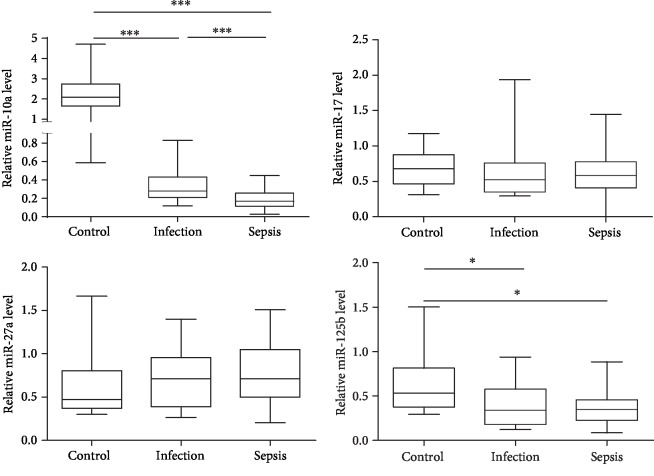
PBMC miR-10 levels in sepsis. The box and whisker plots represent the levels of miR-10a, miR-17, miR-27a, and miR-125b in PBMC of healthy controls (n = 20), infection patients (n = 21), and sepsis patients (n = 41). The plot shows the median (lines within boxes), interquartile range (bounds of boxes), and error bars (upper and lower ranges). ∗p < 0.05 and ∗∗∗p < 0.001.